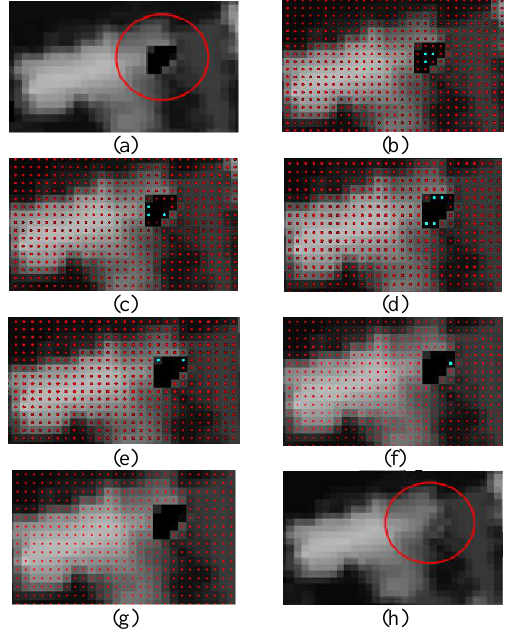
Figure 3. The result of the algorithm in cluster outlier: (a) Before (b) Detected points as outlier in 1 st iteration (c) Detected points as outlier in 2 nd iteration (d) Detected points as outlier in 3 rd iteration (e) Detected points as outlier in 4 th iteration (f) Detected points as outlier in 5 th iteration (g) Removed points as outlier (h) Interpolating the remaining points (Final result)